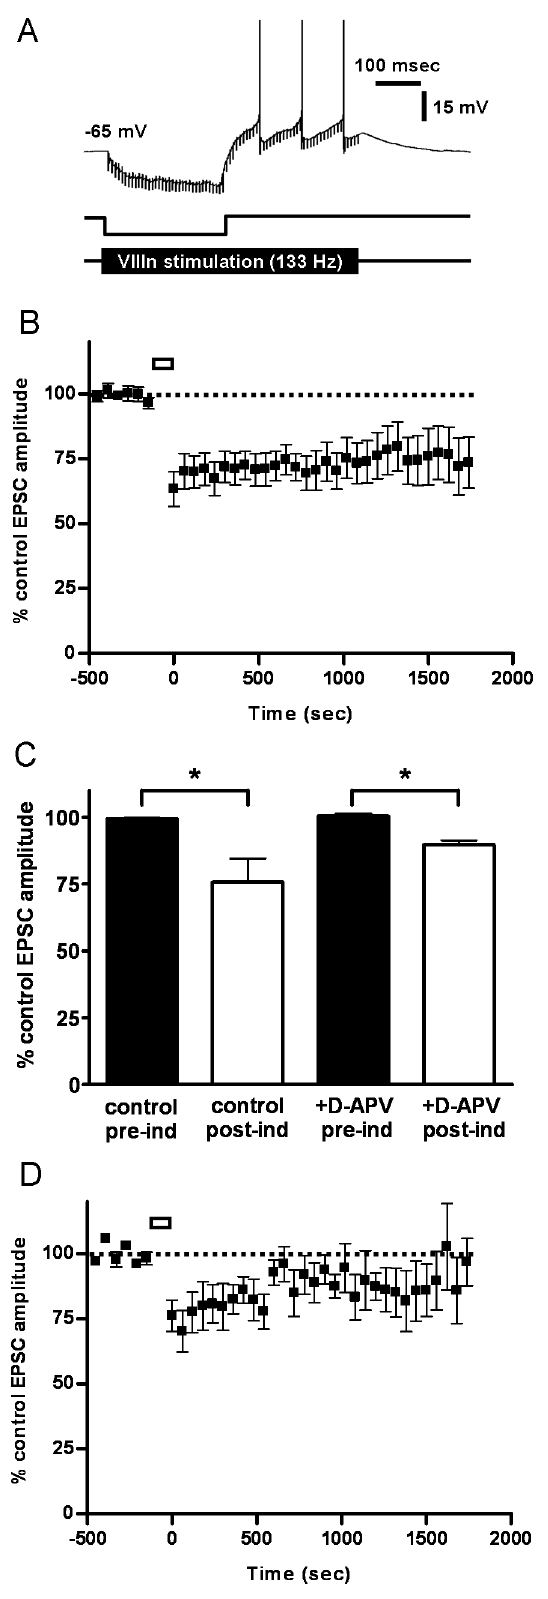
Figure 4. Plasticity of the vestibular afferent synapse induced with the pause-rebound protocol. A, Example of the pause- rebound (PR) induction protocol (after Pugh, 2006 # 16]) in an